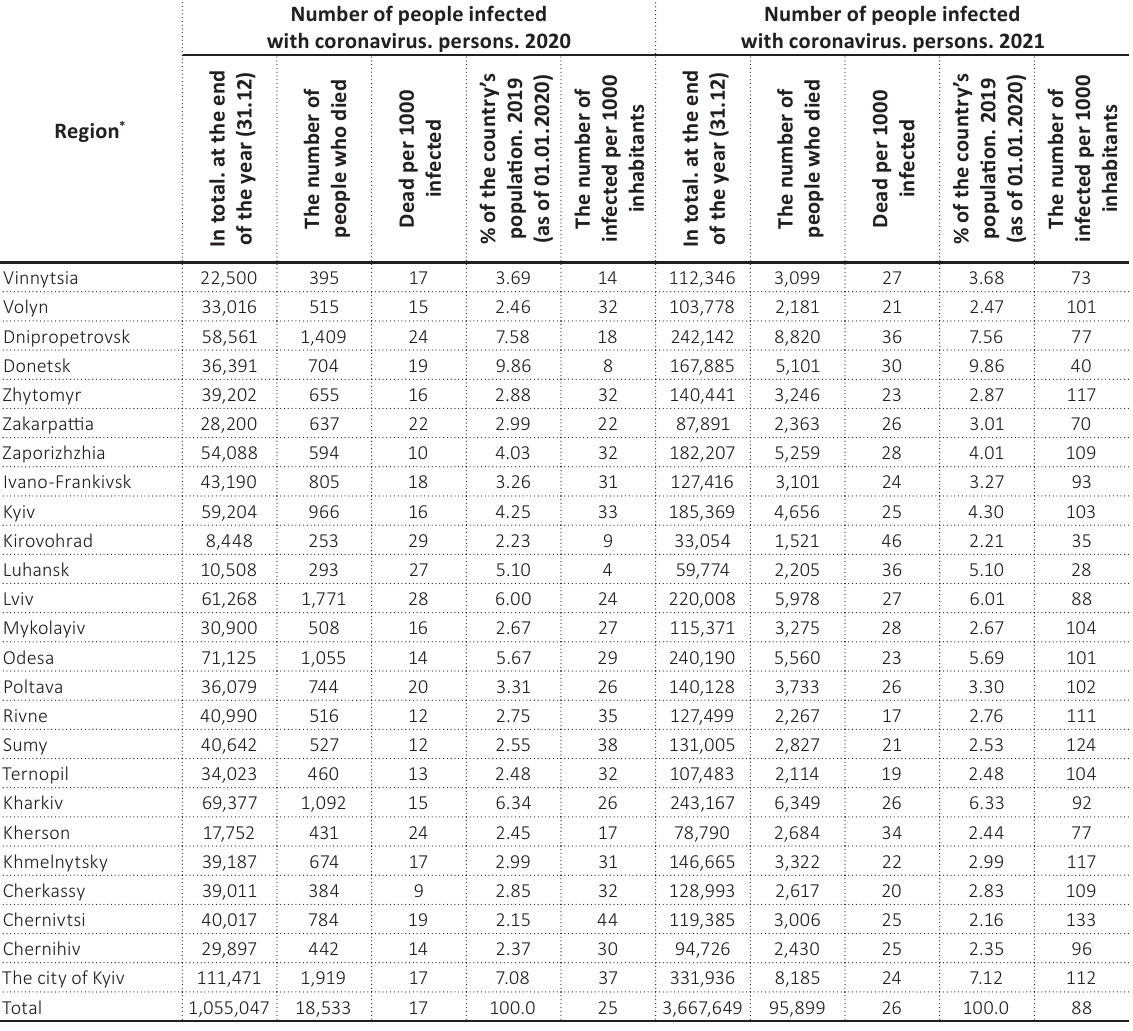
Table A2. Situation with coronavirus infection, by region of Ukraine, %, 2020–2021 Source: Calculated by the authors based on aggregated data (State Statistics Service of Ukraine, n.d.; National Security and Defense Council of Ukraine, n.d.). Number of people infected Number of people infected with coronavirus. persons. 2020 with coronavirus. persons. 2021 Region *